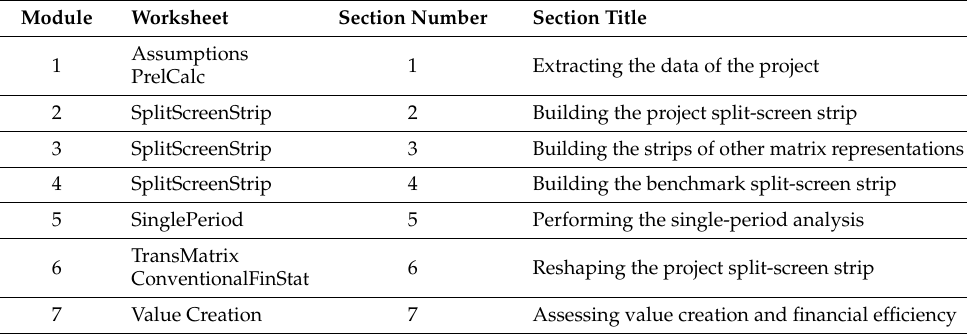
Table 3. Structure of the paper and of the spreadsheet